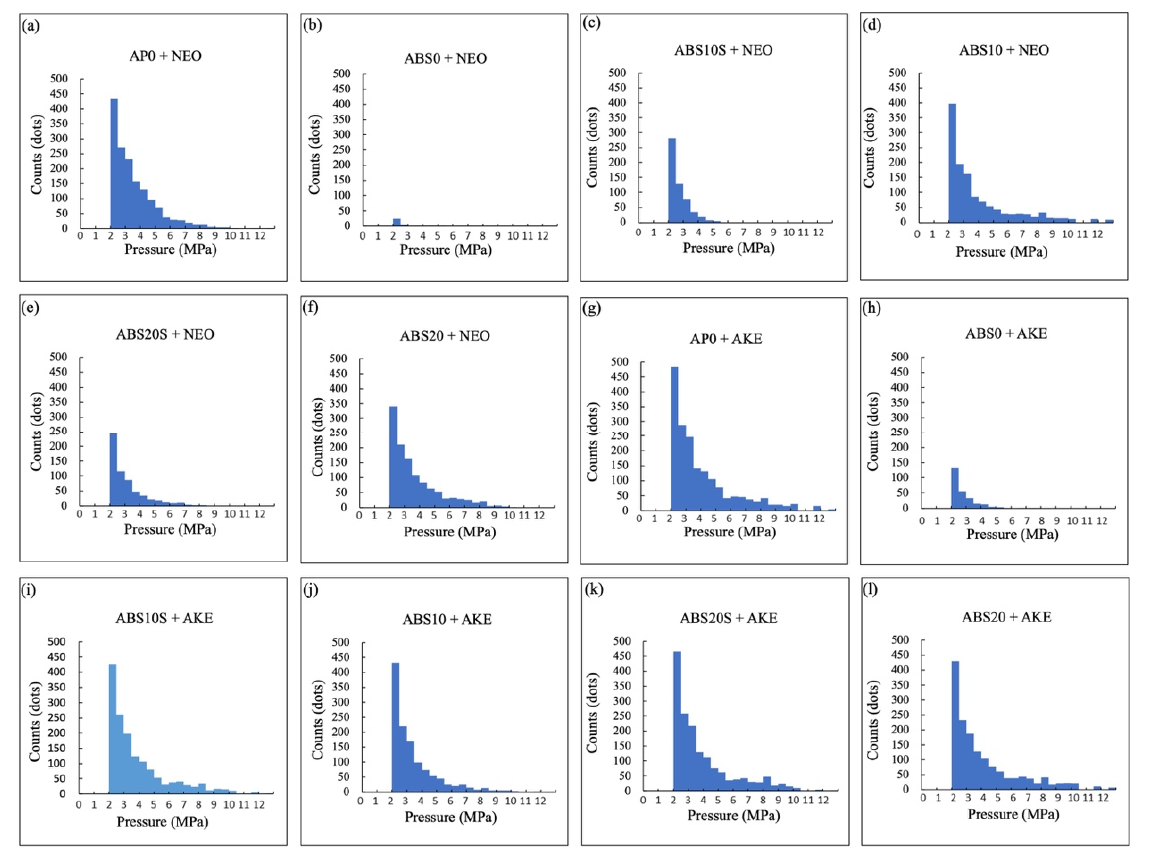
Figure 10. Pressure histograms obtained using pressure measurement films. ( a ) AP0 + NEO, ( b ) ABS0 + NEO, ( c ) ABS10S + NEO, ( d ) ABS10 + NEO, ( e ) ABS20S + NEO, ( f ) ABS20 + NEO, ( g ) AP0 + AKE, ( h ) ABS0 + AKE, ( i ) ABS10S + AKE, ( j ) ABS10 + AKE, ( k ) ABS20S + AKE, and ( l ) ABS20 + AKE. One dot represents an area of 0.125 × 0.125 mm 2 .